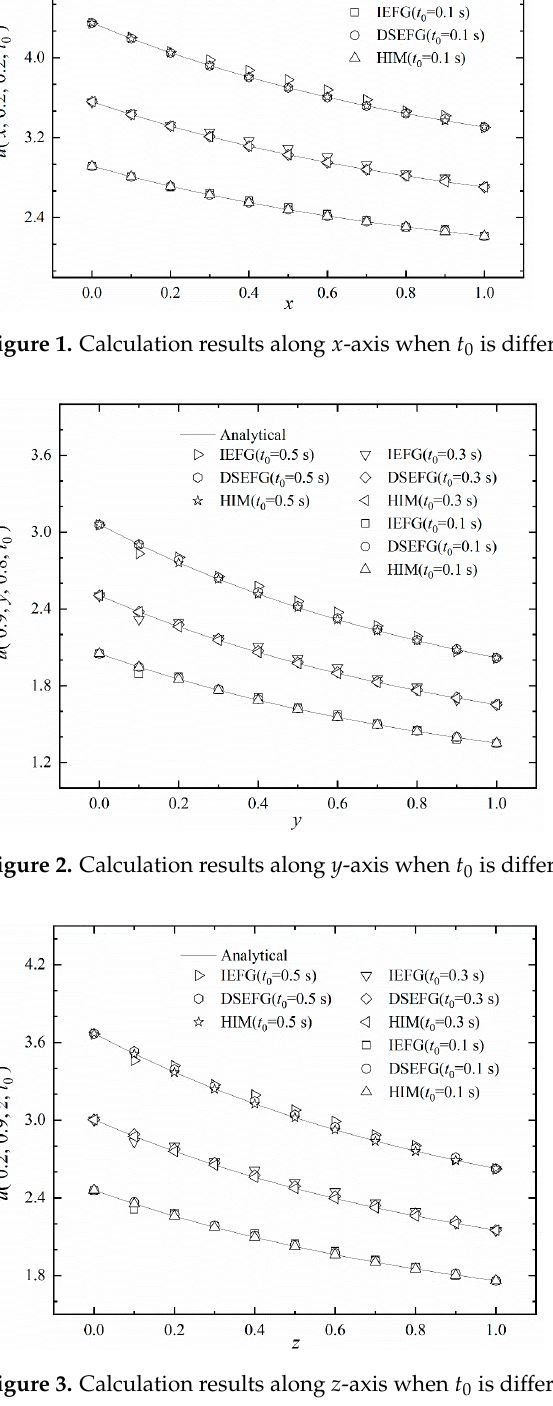
t is different. 0